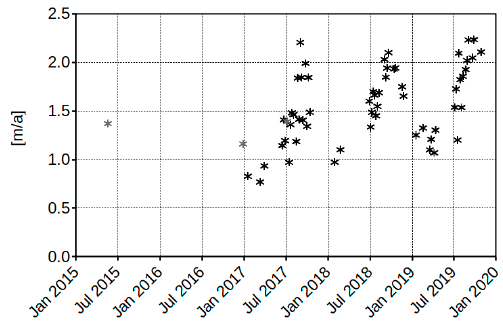
Figure 6. ( a ) Becs-de-Besson rock glacier (Val de Réchy, Switzerland) with positions of the two permanent GNSS stations used for validation (BdB1 and BdB2) and of the Sentinel-1 InSAR time series of Figure 7 (BdB3), image data are from Google, DigitalGlobe; ( b ) TerraSAR-X interferogram from 01.10.2012 to 12.10.2012, 2 π ⇔ 1.6 cm; ( c ) Sentinel-1 interferogram from 07.09.2018 to 13.09.2018, 2 π ⇔ 2.8 cm. The black arrow indicates the satellite line-of-sight.